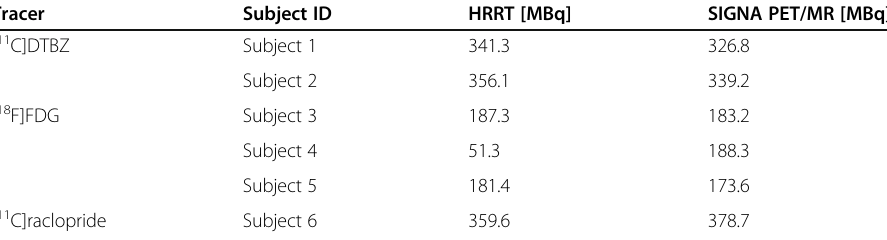
Table 4 Injected activity of the respective tracer for each subject at start of the acquisition